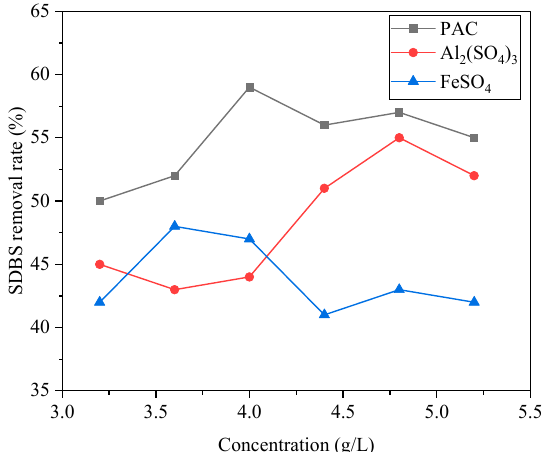
Figure 3. Influence of different flocculants on SDBS removal.